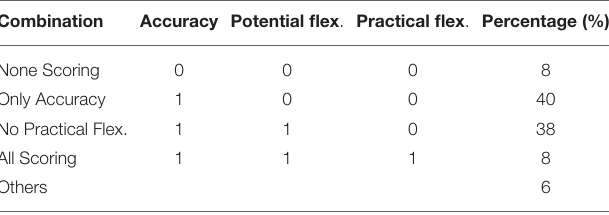
TABLE 4 | Percentage of scoring combinations in accuracy, potential and practical flexibility ( N = 158). Combination